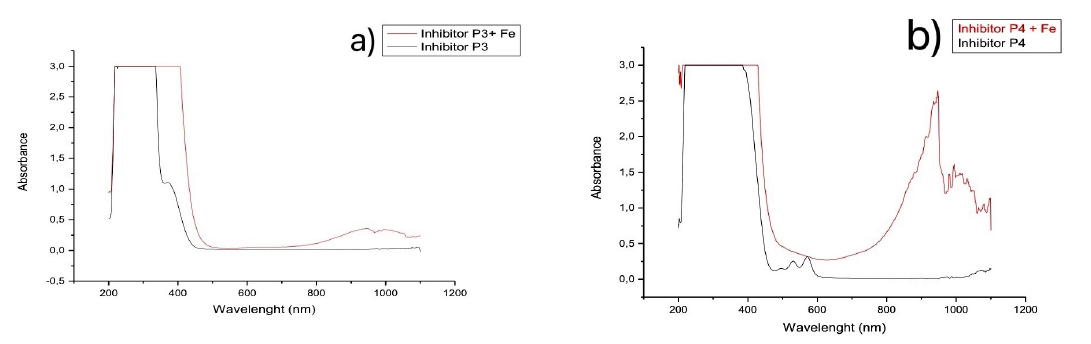
Figure 10. UV-visible spectra obtained for 5.0 M HCl solution containing 10-3 M of (a) P3 or (b) P4 before (Black) and after (Red) 6 days of immersion of ordinary mild steel.